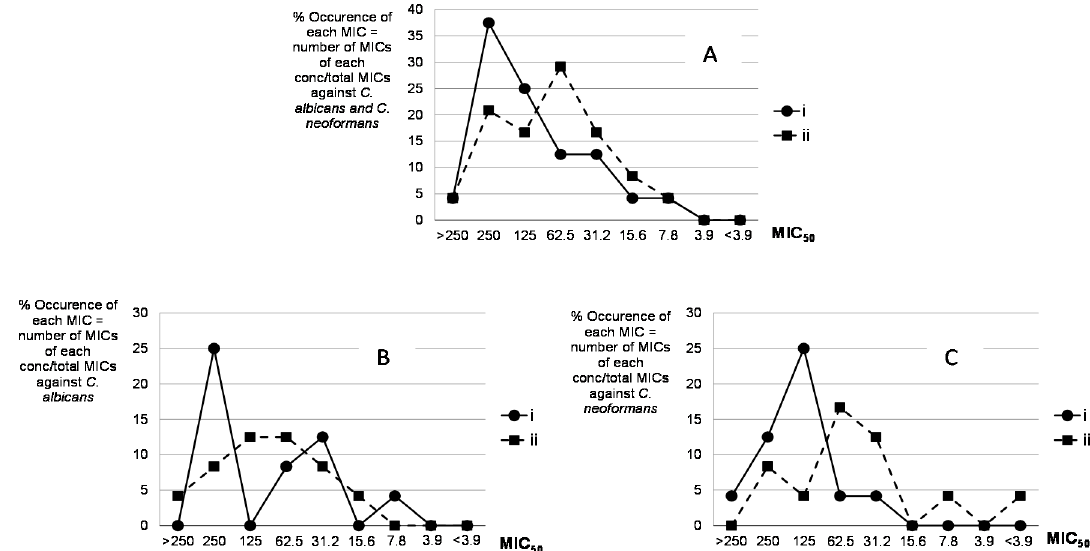
Figure 2. % Occurrence of each MIC value = number of MICs of each conc/total MICs acting against [( A ) C. albicans + C. neoformans ( Ca + Cn ) (24 MIC 50 values were considered 100%); ( B ) C. albicans (12 MIC 50 values were considered 100%); ( C ) C. neoformans (12 MIC 50 values were considered 100%]; (i) includes compounds 15 – 26 with the diaryl-azole moiety in the p -position of ring A ; (ii) includes compounds 27 – 38 with the same moiety in the m -position.